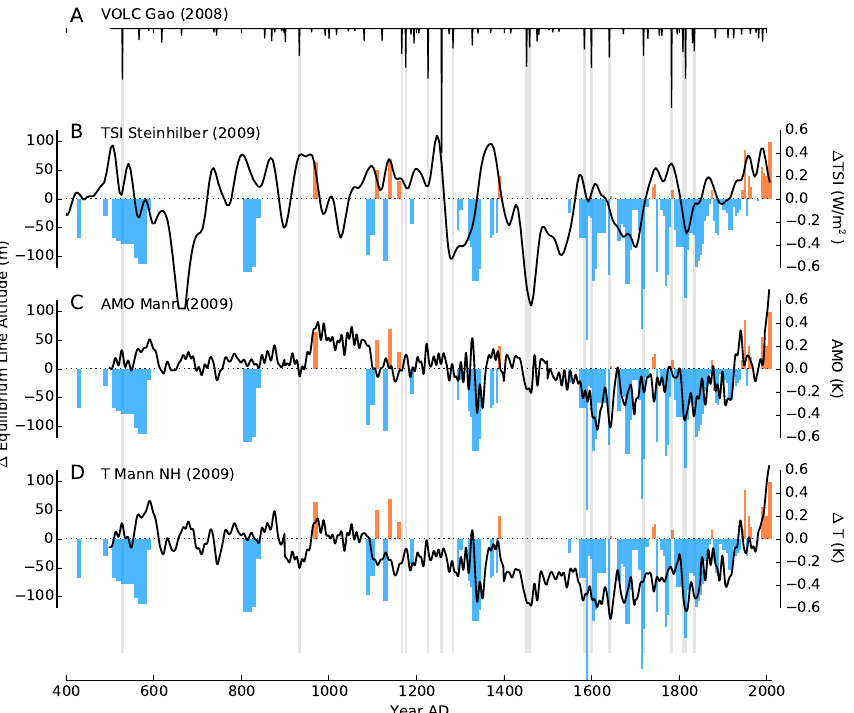
Fig. 3. ELA variation reconstruction for the time span 400–2010 compared to unsmoothed climate records from different proxies. (A) Northern Hemisphere stratospheric sulfate loading from explosive volcanism (Gao et al., 2008). (B) total solar irradiance (TSI, red; Stein- hilber et al., 2009), (C) AMO index reconstruction (black; Mann et al., 2009), (D) multi-proxy temperature reconstruction for the Northern Hemisphere (yearly average) (Mann et al.,